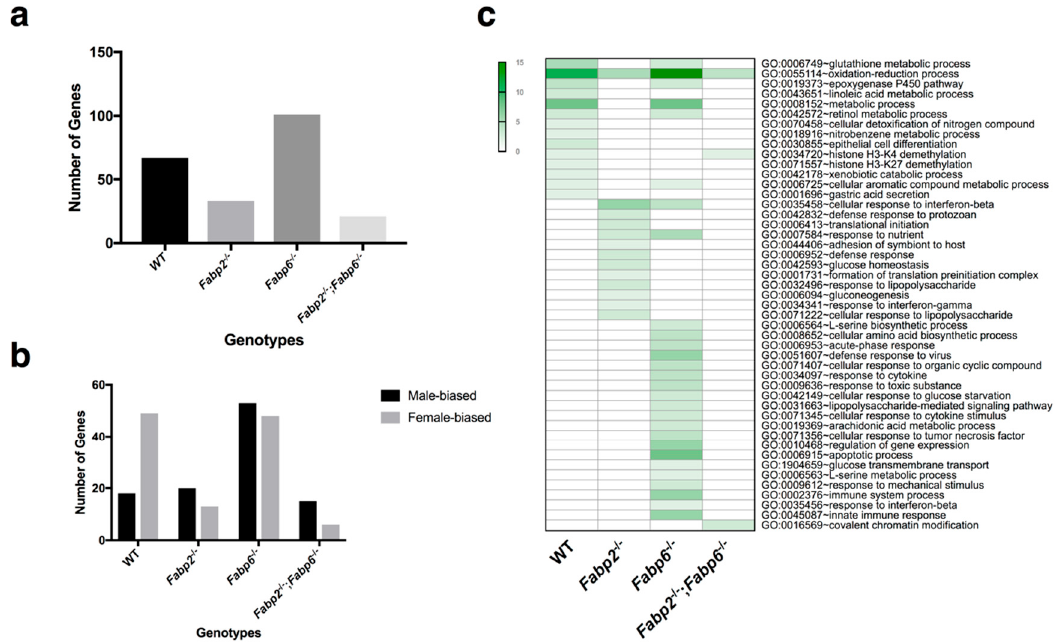
Figure 1. Sex-biased genes and functional annotation (gene ontology: biological process, GO: BP). ( a ) Comparison of the number of sex-biased genes identified in wild-type (WT), Fabp2 – / – , Fabp6 – / – , and Fabp2 – / – ; Fabp6 – / – mice. ( b ) The number of male- and female-biased genes in the small intestinal transcriptome across all genotypes. ( c ) Comparison of the biological processes enriched ( p -value < 0.05) using sex-biased genes. The numbers of genes involved in each biological process are represented by the green color, darker shades indicate a greater number of genes. See Supplementary Table S1 for a complete list of sex-biased genes .